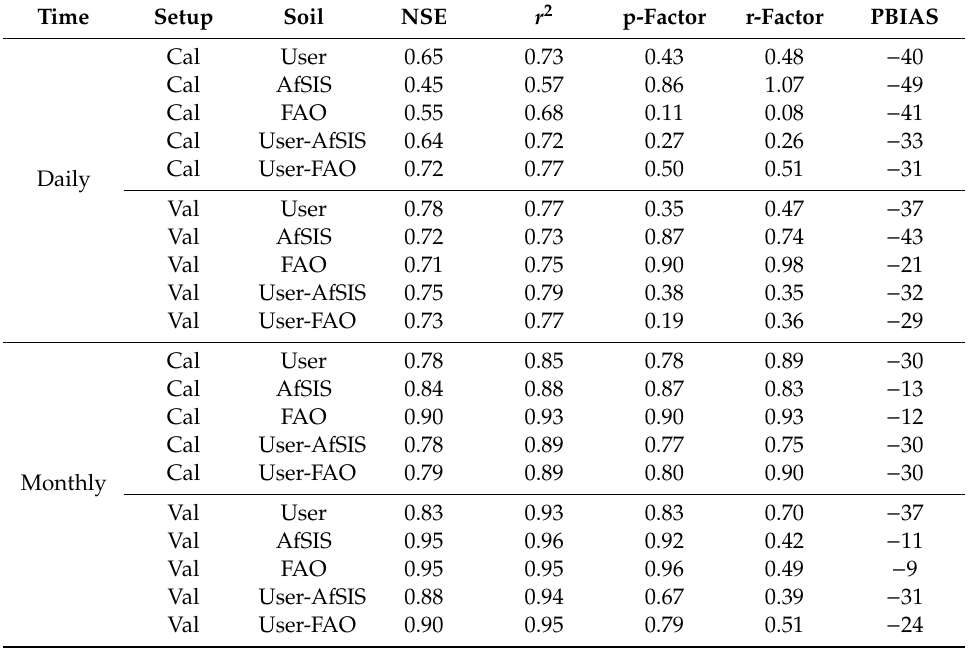
Table 3. Evaluation measures for daily and monthly streamflow simulations using di ff erent soil datasets.